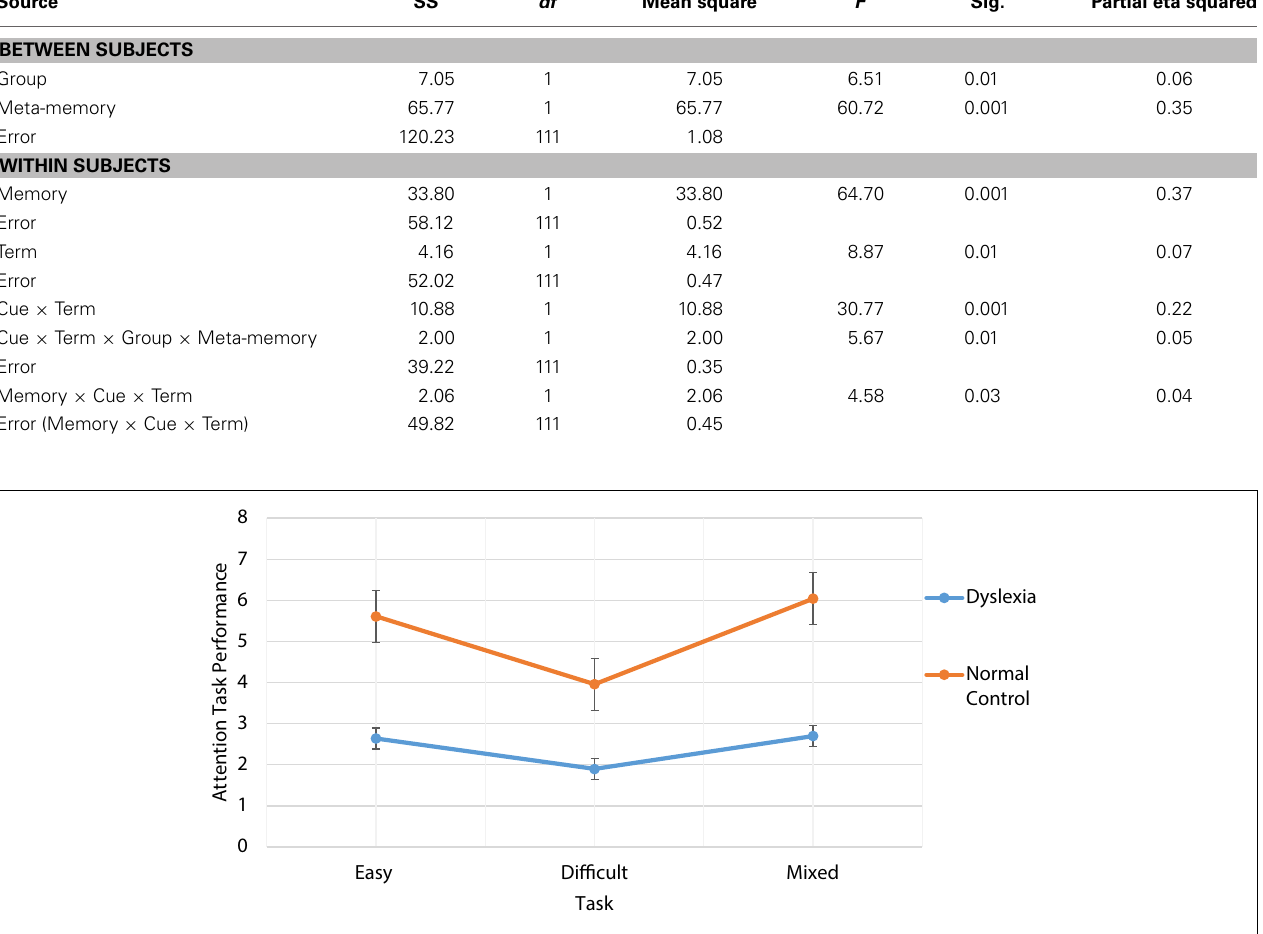
FIGURE 1 | Performance of dyslexic and normal control of easy difficult and mixed attention task.